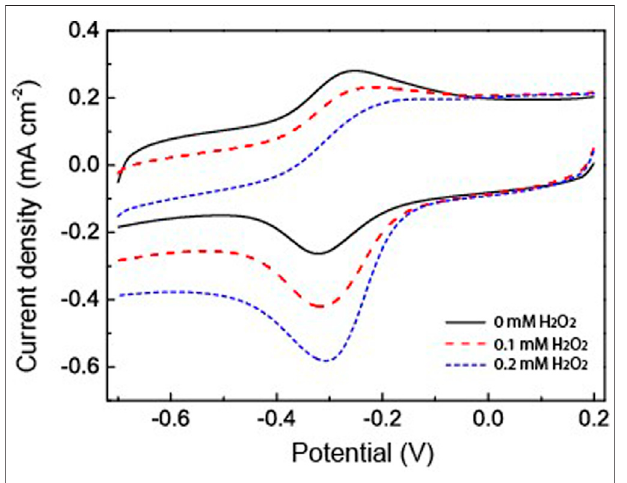
FIGURE 6 | CV curves of HRP/Au NPs-PDA-PAA-graphene with and without H 2 O 2 in PBS (pH 7.4). Scan rate: 50 mV/s.